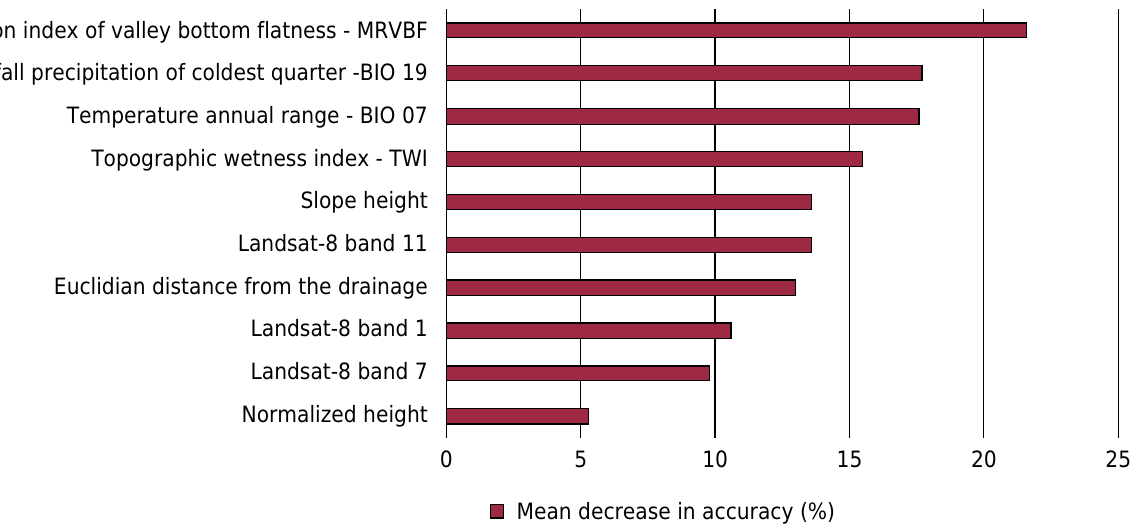
Figure 3. Importance of covariates in the soil mapping, measured by the Gini index as implemented in the Random Forest model run with RFE covariate